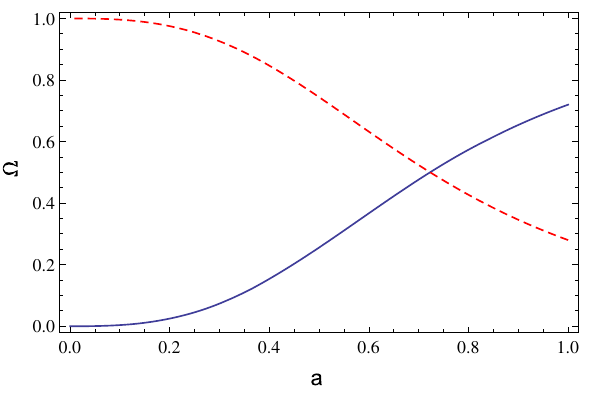
Fig. 2 The evolutional behaviors of the density ratio parameters for the quintessence field ( solid line ) and the matter ( dashed line